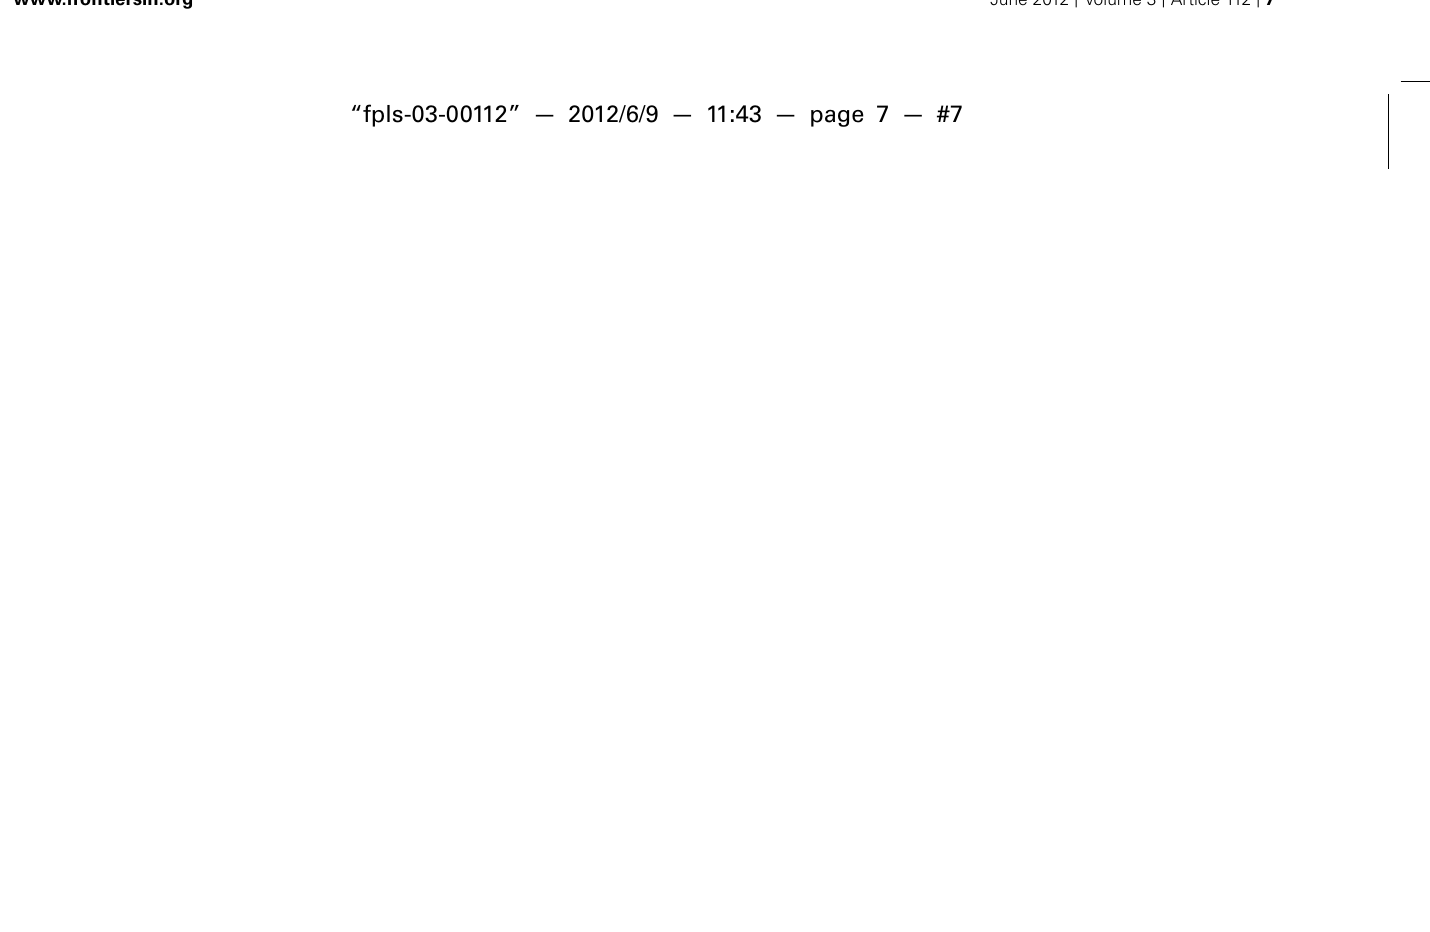
( Figure 1D ): B55 was originally isolated from a 35S-etr1